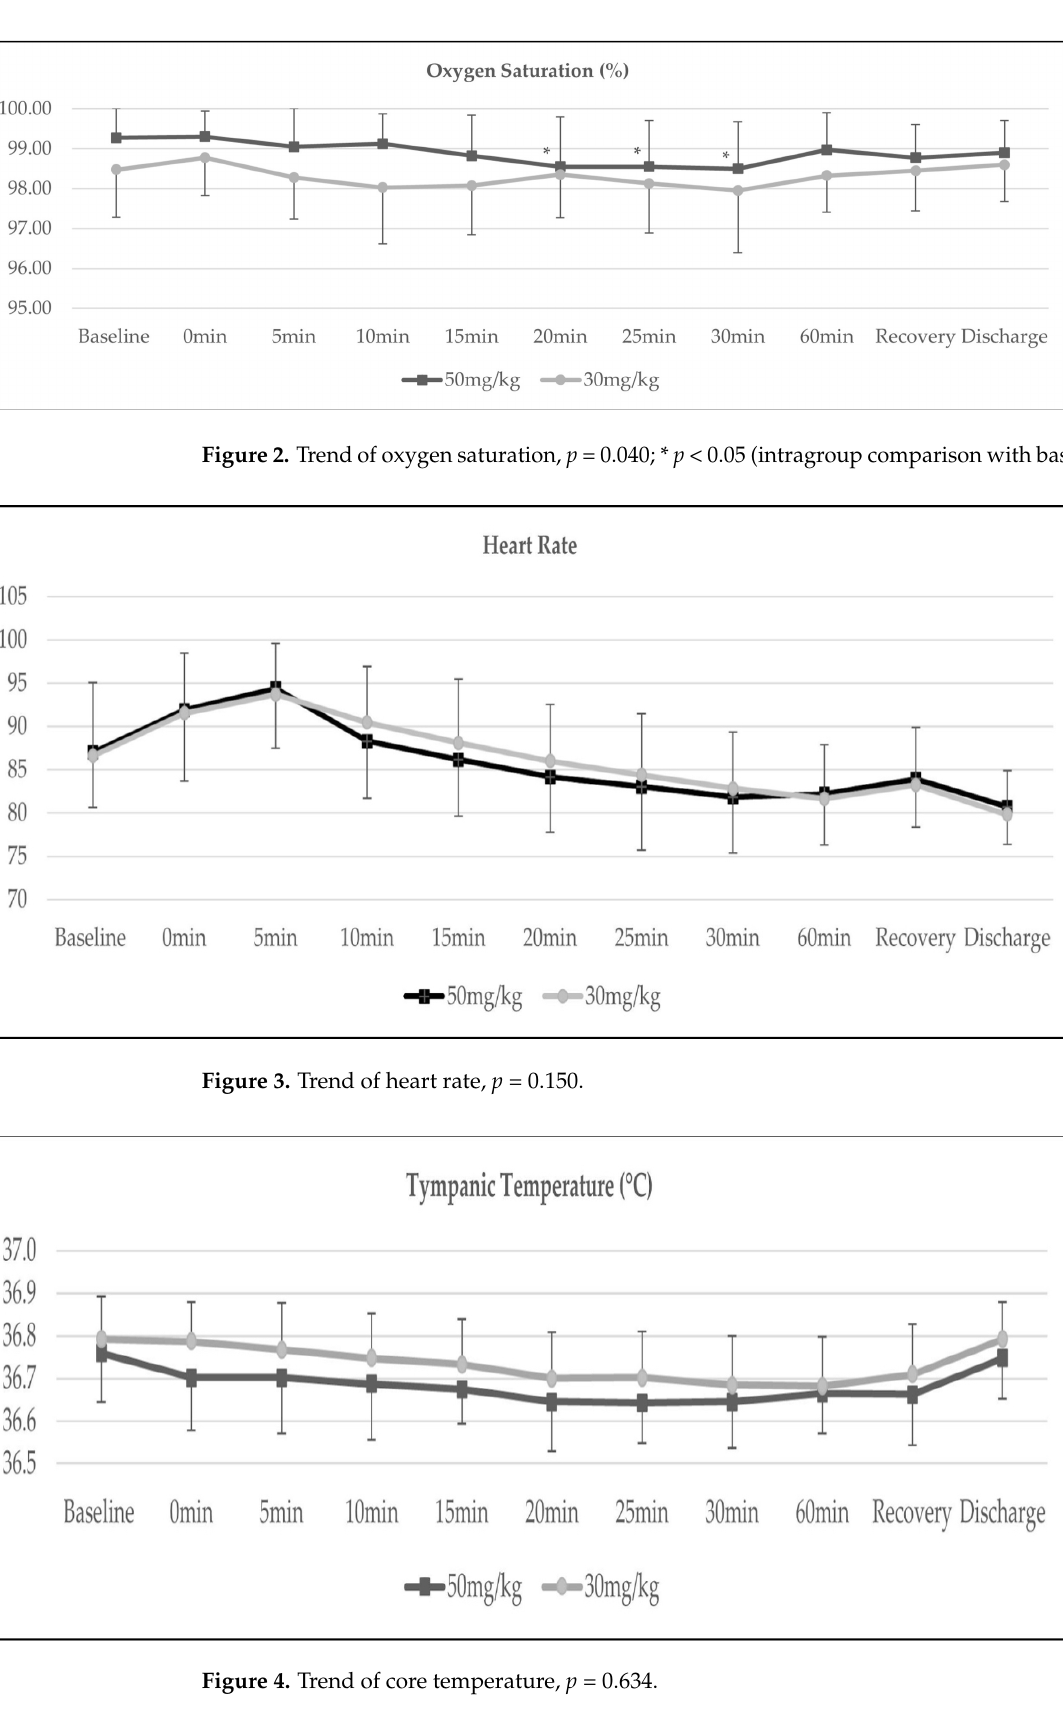
0.006 and 0.004, respectively).